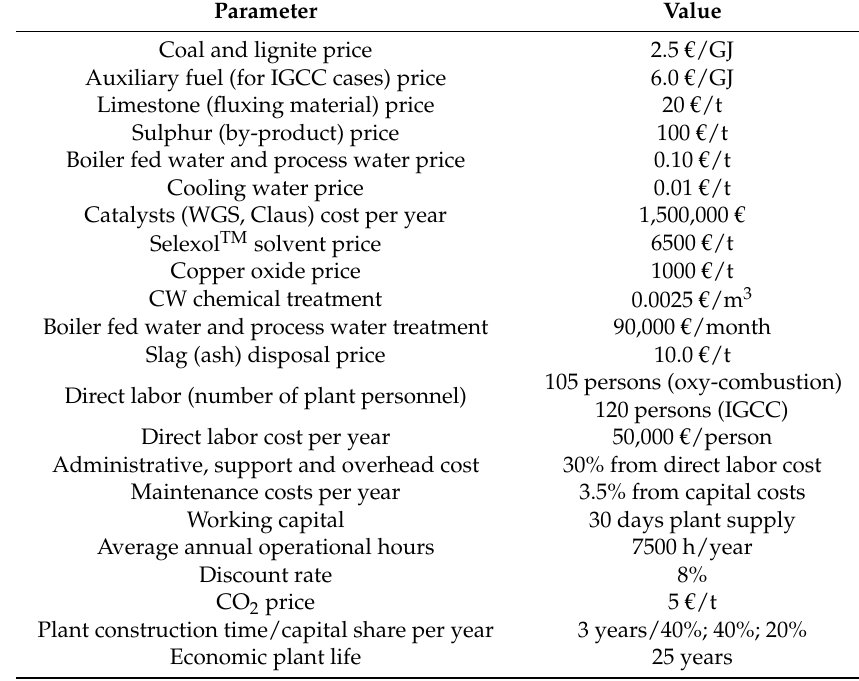
Table 4. Economic assumptions used for assessment of O&M